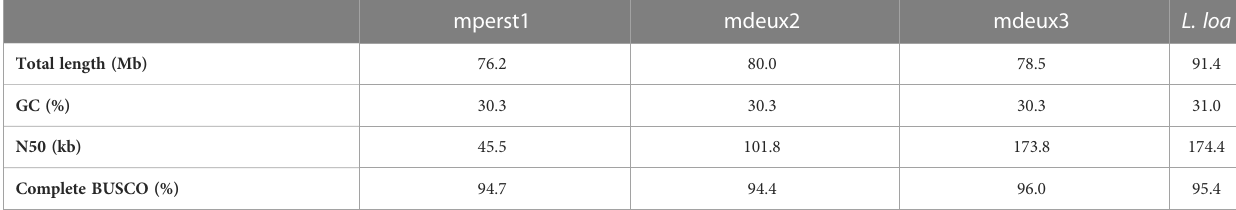
TABLE 2 Comparison of genome assemblies mperst1, mdeux2 and mdeux3 to L. loa . A more detailed comparison to other fi larial species can be found in Supplementary Table 4.